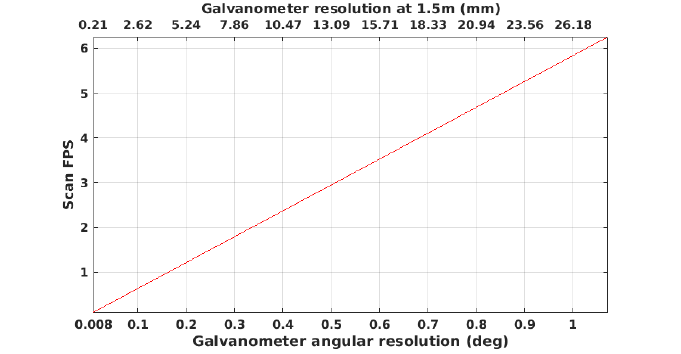
Figure 2. Laser scanner frame